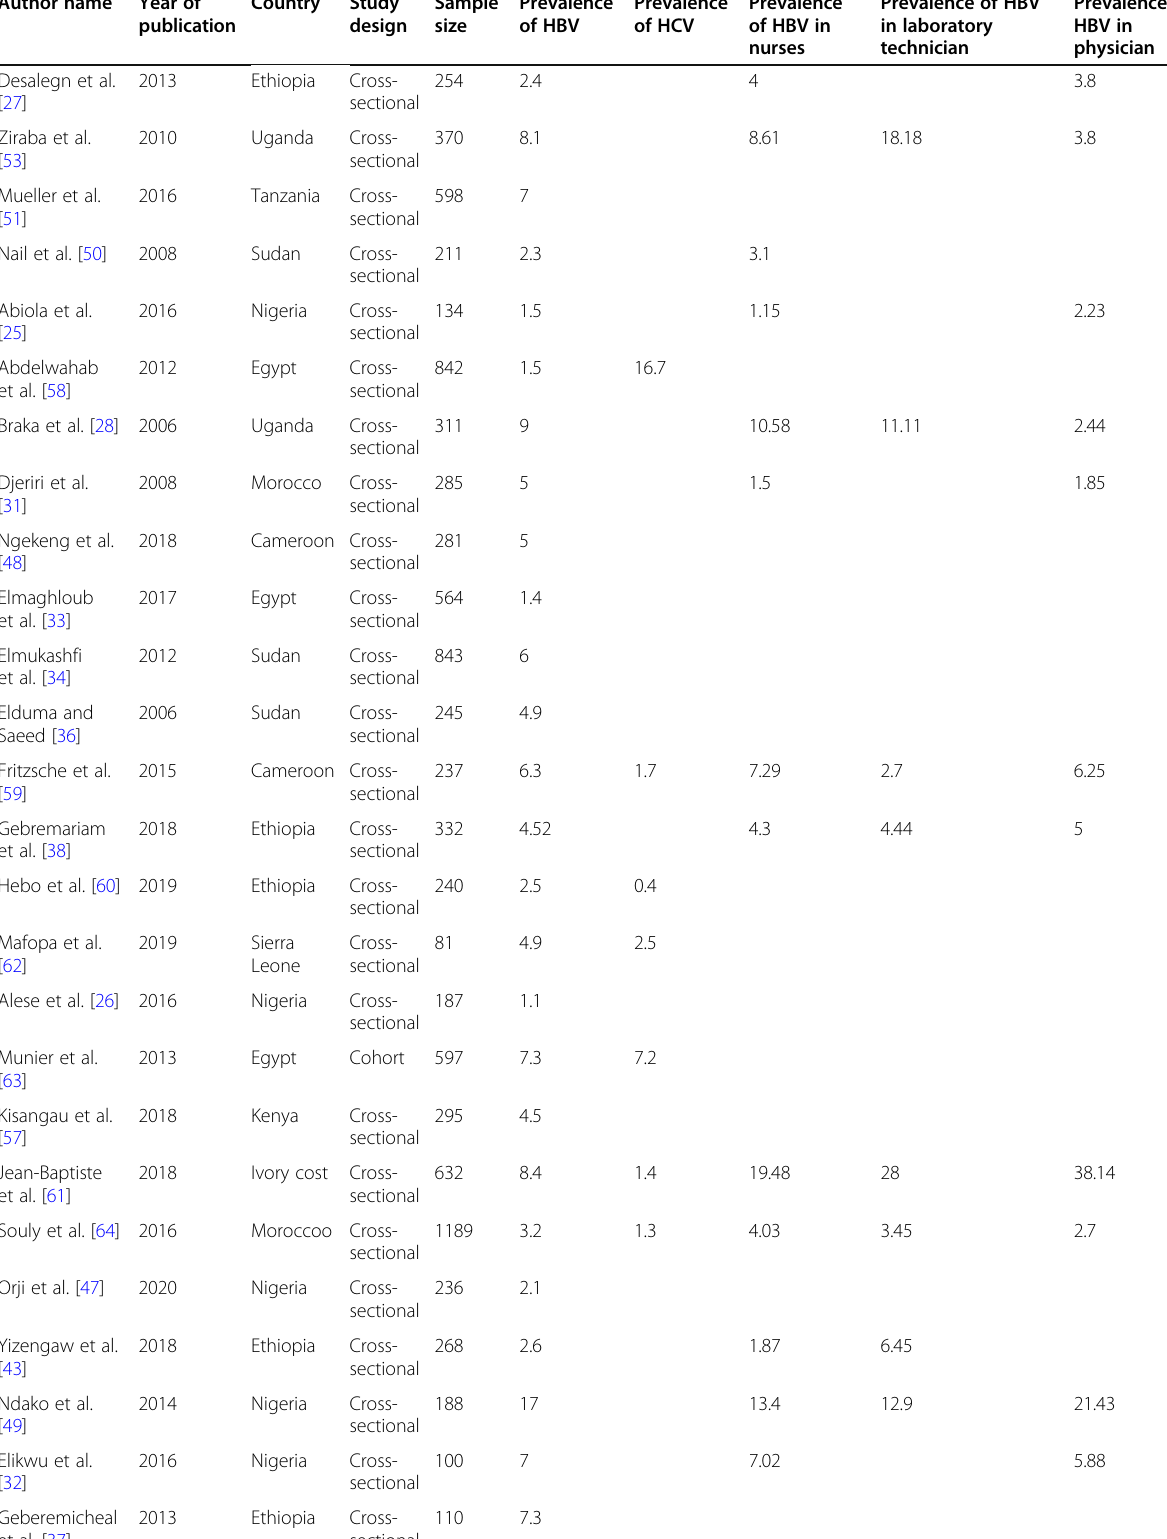
Table 1 Characteristics of included studies in meta-analysis on prevalence of hepatitis B and C in Africa Author